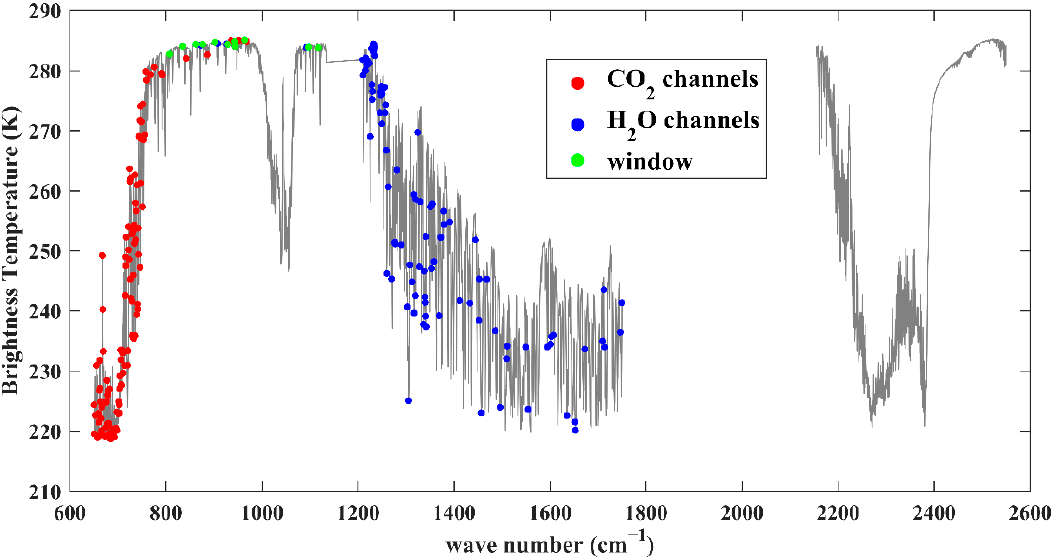
Figure 2. Channels used in NNs retrieval. Red, blue and green dots represent channels selected in CO 2 , H 2 O and window band, respectively.